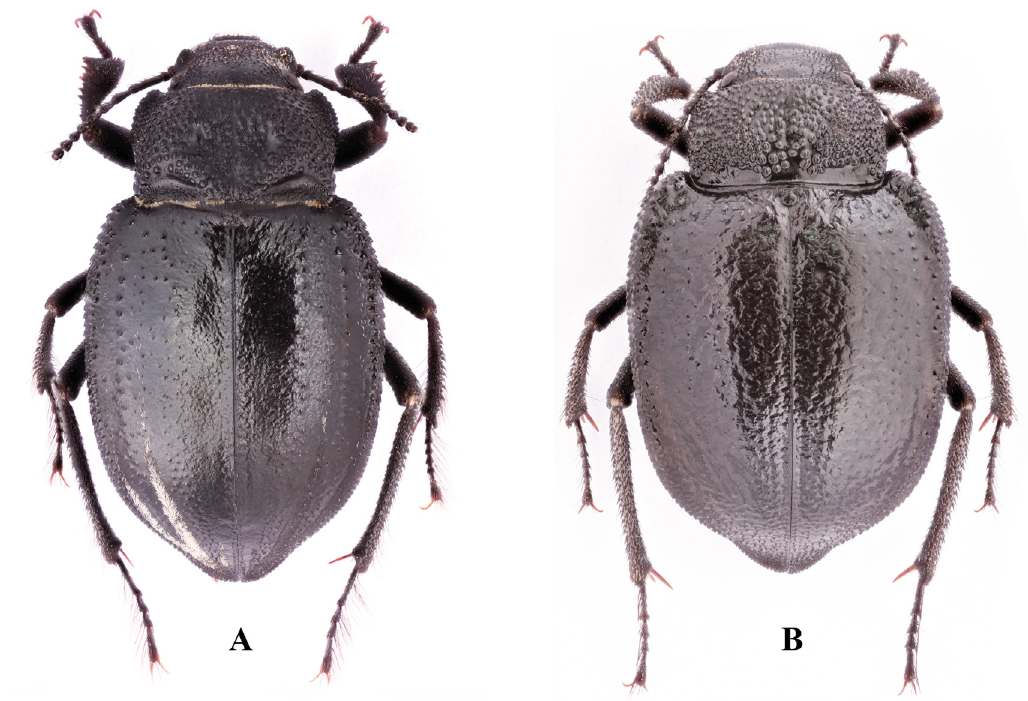
Fig. 6. Species of the genus Platyope Fischer von Waldheim, 1820, habitus, dorsal view. A . P. proctoleuca proctoleuca Fischer von Waldheim, 1820, ♂ (ZIN). B . P. ordossica Semenov-Tjan-Shansky, 1907, ♂